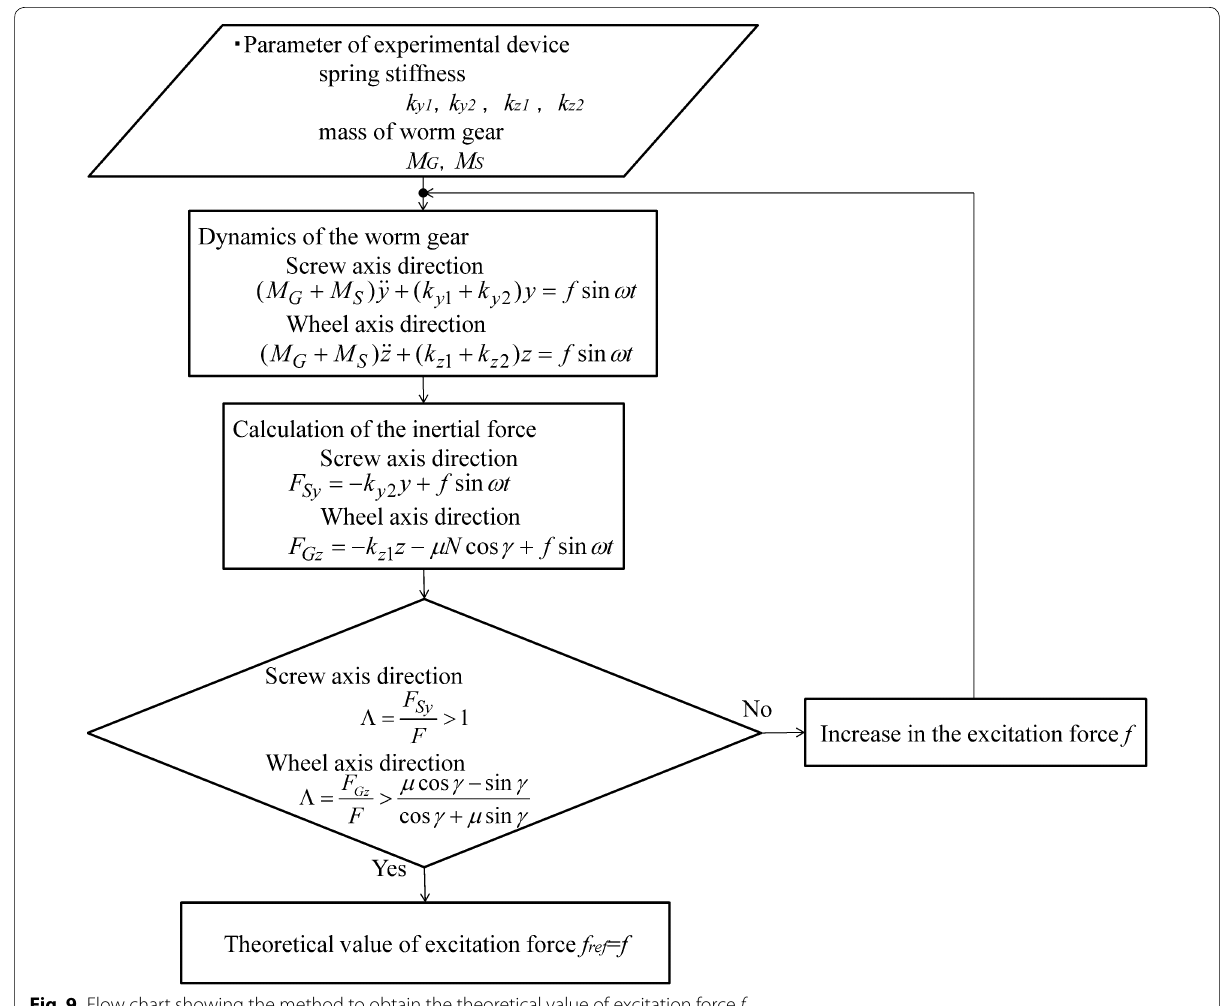
Fig. 9 Flow chart showing the method to obtain the theoretical value of excitation force f